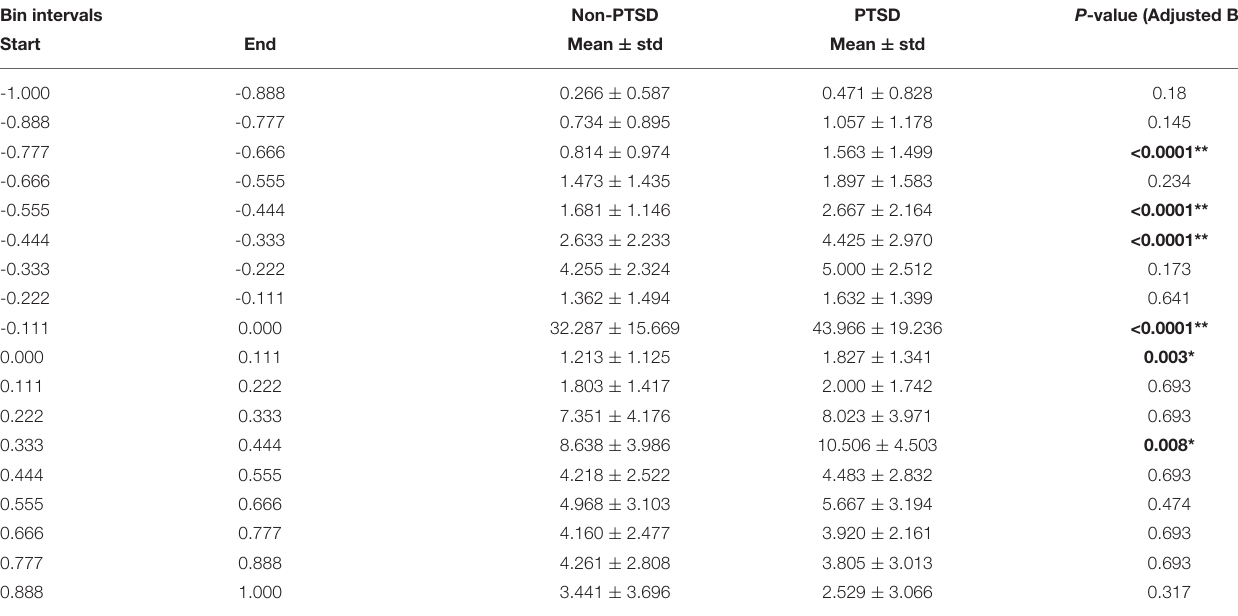
TABLE 5 | Average binned sentiments per group (bins =